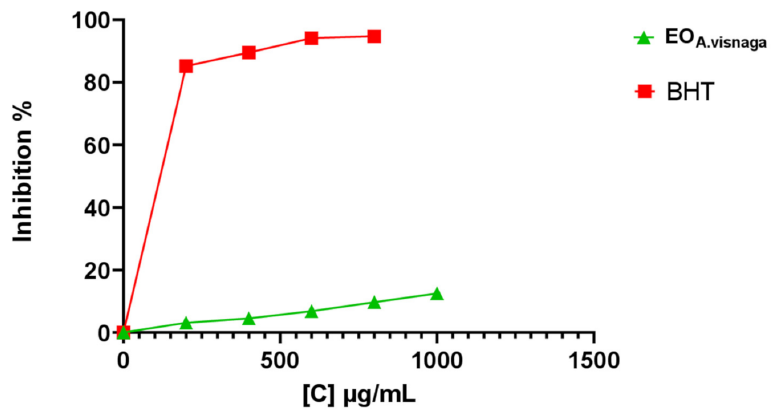
Figure 1. Percentage inhibition of the DPPH by different concentrations of essential oil of A. visnaga L. and standard (results expressed as means ± SD, of three parallel measurements ( p < 0.05)). EO: essential oil; BHT: butylated hydroxytoluene.